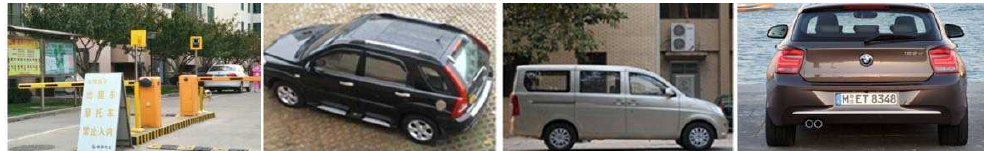
Figure 9. Example of the context scene of a car in regular images.